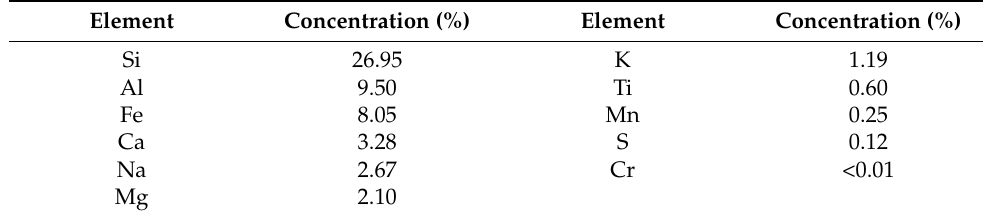
Table 1. Tailings chemical characterization test results using ICP.